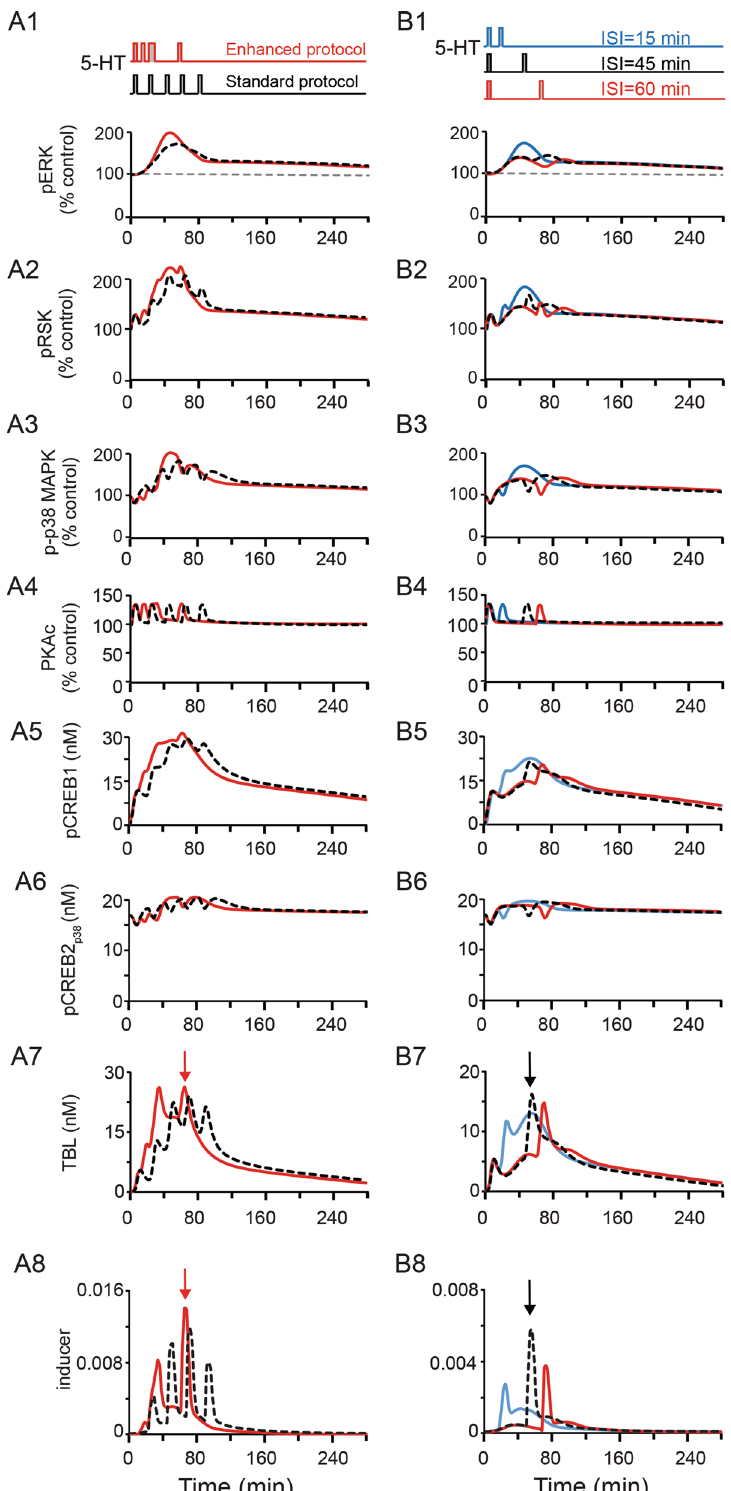
Figure 7. Simulated dynamics of kinases, pCREB1, pCREB2 p38 , TBL and inducer levels after five pulses of 5-HT using the Standard protocol ( A , black curves), or Enhanced protocol ( A , red curves); or two pulses of 5-HT with ISI of 15 min ( B , blue curves), 45 min ( B , black curves) or 60 min ( B , red curves). Arrows represents peak inducer